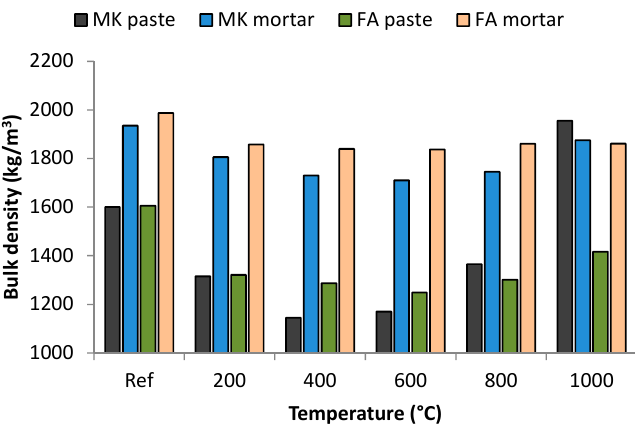
Figure 6. Bulk density of geopolymer samples exposed to elevated temperatures.